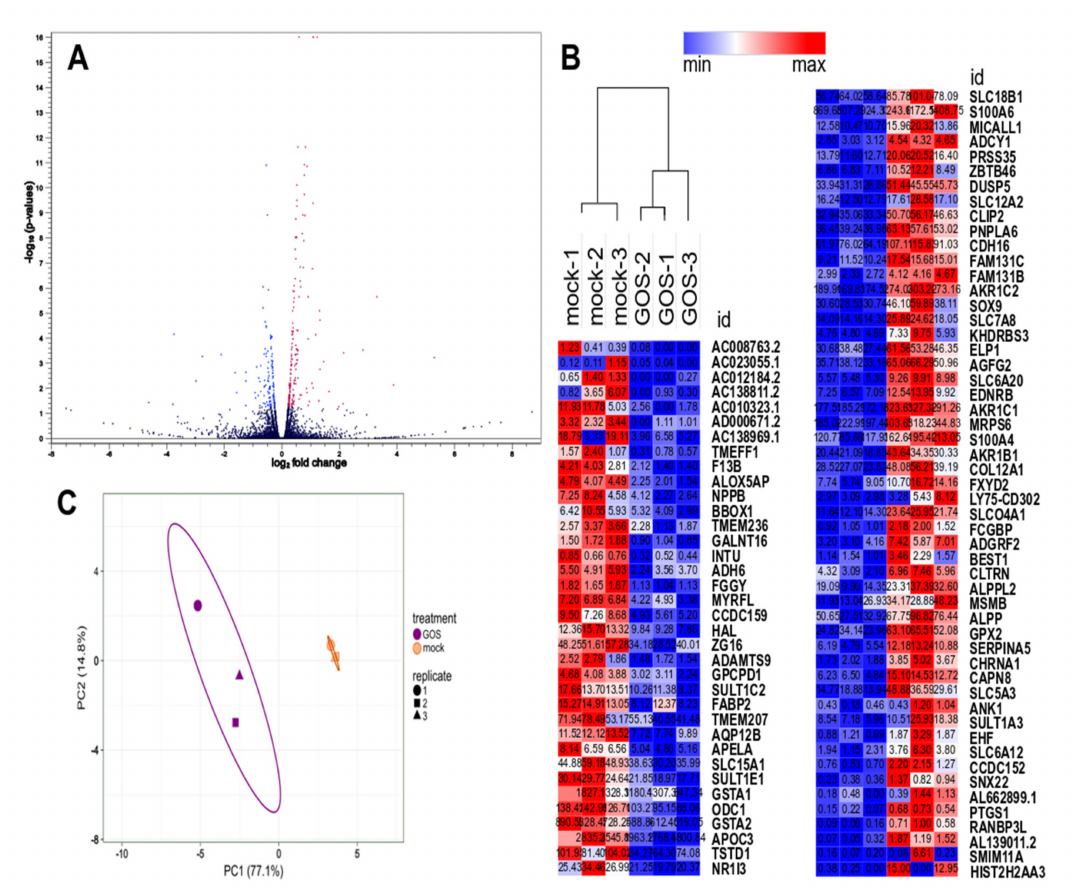
Figure 2. Di ff erentially expressed genes associated with GOS treatment. ( A ) Volcano plot of genes di ff erentially expressed between GOS and GOS mock treatment ( n = 3). The abscissa represents log 2 fold changes in gene expression, the ordinate represents statistical significance of the variations in gene expression, expressed as -log 10 ( p -values). ( B ) Principal component scatter plot showing variance of the biological replicates for each treatment ( n = 3). Axis x and y show principal components 1 (PC1) and 2 (PC2) that explain 77.1% and 14.8% of the total variance respectively. Prediction ellipses indicate probability 0.95 that a new observation from the same group will fall inside the ellipse; N = 6 data points. ( C ). Heatmap displaying di ff erentially expressed genes for GOS and mock treatments. Rows and columns are clustered using Pearson’s correlation distance and average linkage. Data are presented as normalized transcripts count (TPM) with | FC | ≥ 1.5 and q -value <